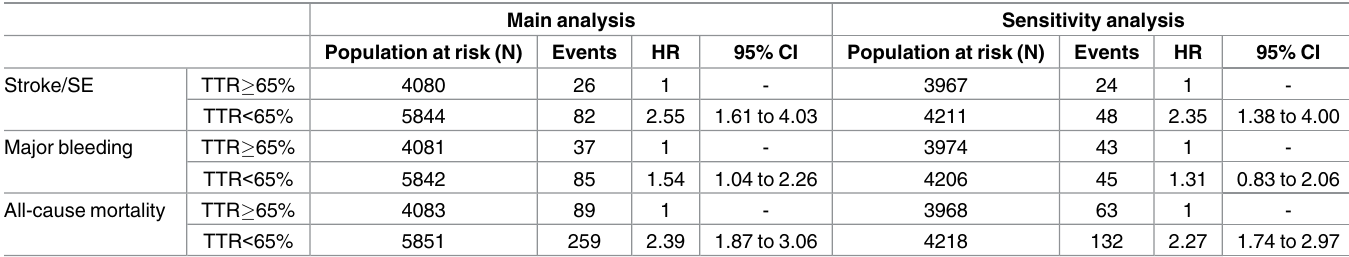
Table 5. Adjusted hazard ratios for 1-year clinical outcomes by proportion of time in therapeutic range for the main analysis and sensitivity anal- ysis (excluding international normalised ratio readings and events during the first 3 months of treatment). Main analysis Sensitivity analysis Population at risk (N) Events HR 95% CI Population at risk (N)